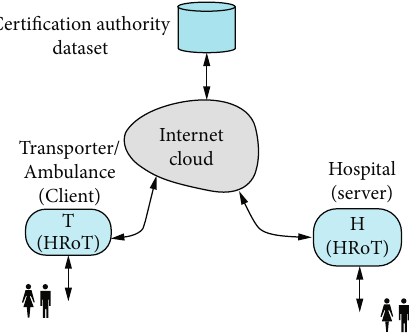
Figure 6: Ambulance-based smart emergency medical response